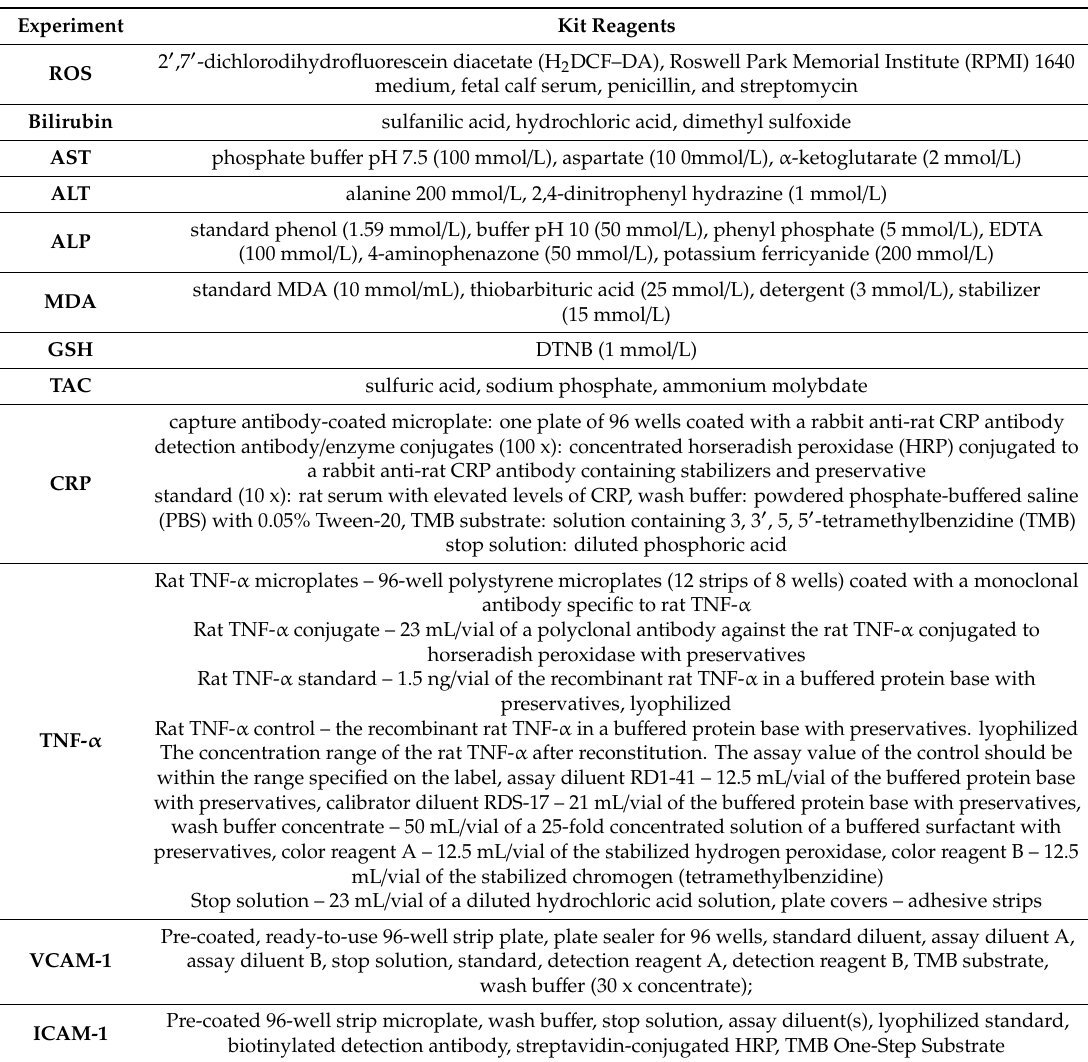
Table 5. Kit reagents used in the di ff erent